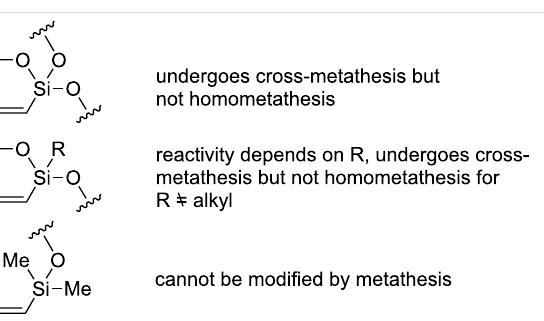
Figure 2: The scope and limitations of metathesis in transformations of vinyl-substituted siloxanes and silsesquioxanes.